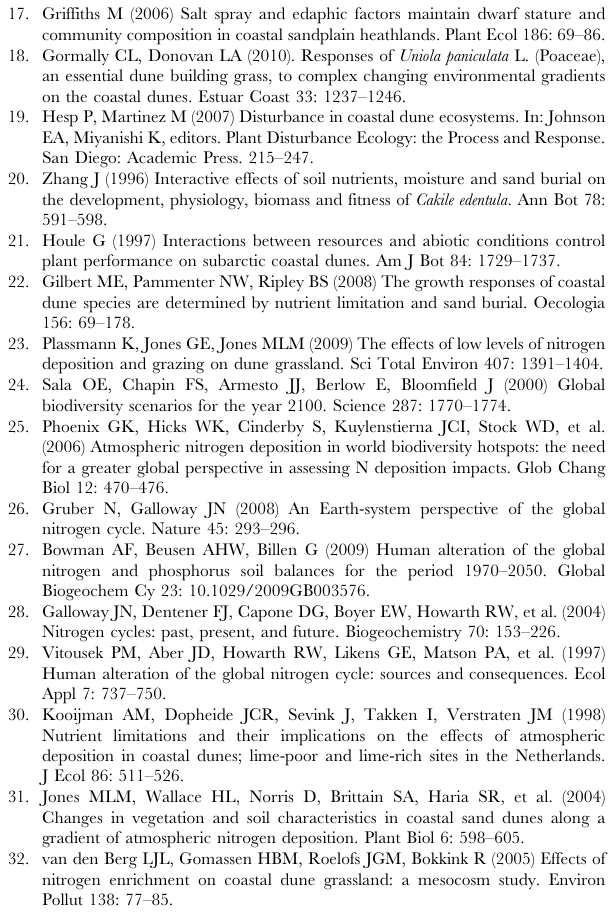
Table S1 PERMANOVA on Euclidean distances of plants assigned to different treatments replicated in two sites within two areas selected at random along the study dune system at the beginning of the experiment (May 2010). Table S2 PERMANOVA on Euclidean distances of plants subjected to different treatments replicated in